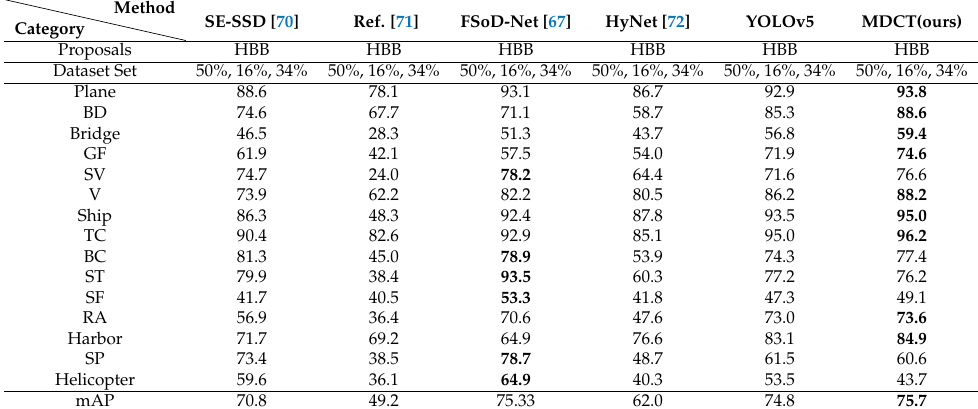
Figure 7. Results predicted by MDCT on DIOR, which contains the ship, harbor, bridge, vehicle, baseball field, overpass, dam, golf field, stadium, and train station. Table 2. Results of different detection methods on the DOTA dataset, the highest AP in each category is shown in bold. The mAP ( × 100) represents IOU = 0.5. The Dataset Set represents the training set, validation set, and test